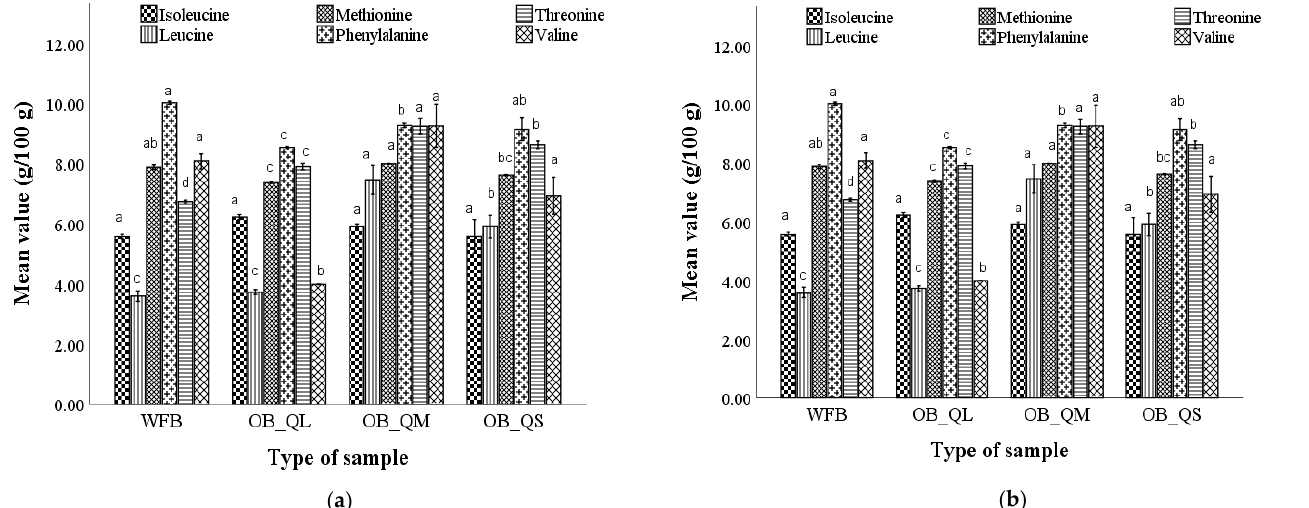
Figure 3. Essential ( a ) and non-essential ( b ) amino acid composition of the bread with the optimal dose of quinoa flour corresponding to the large, medium, and small particle size (OB_QL, OB_QM, and OB_QS) compared to wheat flour bread (WFB). Mean values followed by different letters (a–d) are significantly different ( p <